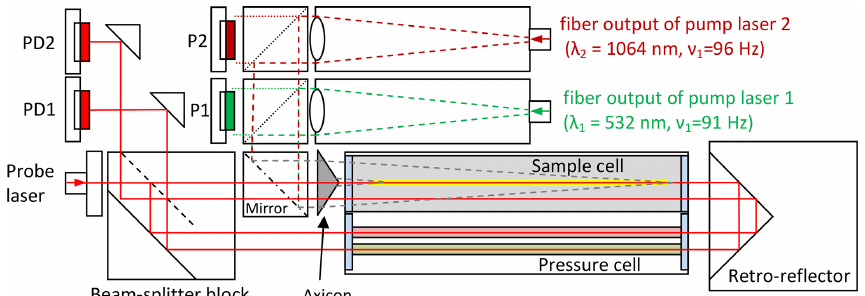
Figure 1. Schematic representation of the PTAAM-2 λ setup.